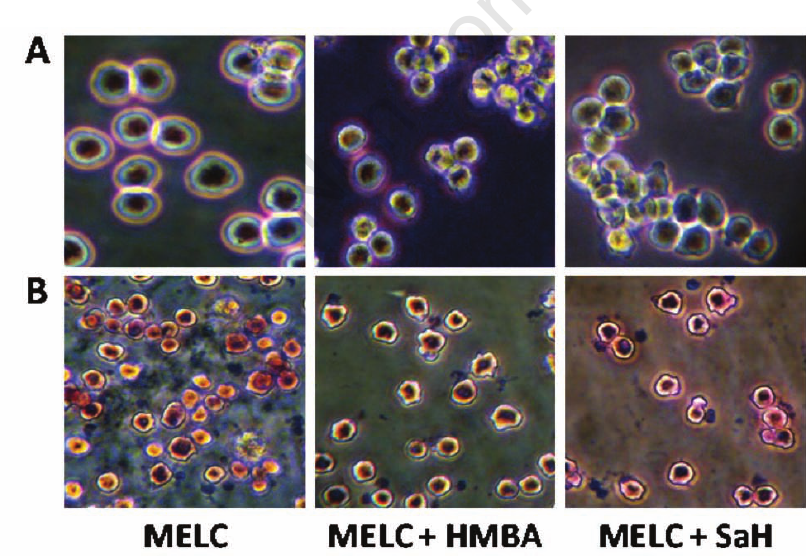
Figure 5. Photographs of murine erythroleukemia cells (MELC) cultures with or without treatment with hexamethylene bisacetamide (HMBA) and acyl amide ACAT inhibitor (SaH). A) Microphotographs taken by using an inverted microscopy of untreated or HMBA and SaH treated- MELC 72 h after culture. B) Microphotograpfs of the above cell cultures examined by inverted microscopy stained with ORO for neutral lipids and counter-stained with hematoxylin for